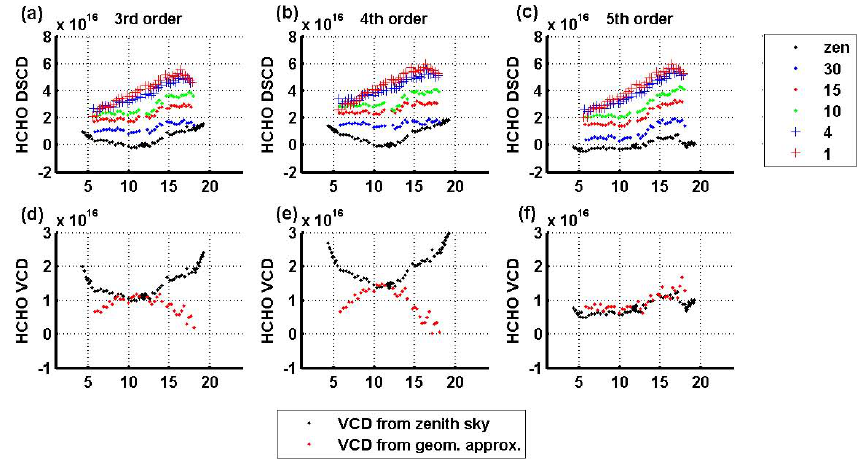
Fig. 9. Effect of the choice of the polynomial order used in the DOAS fit. (a) – (c) : Impact on the HCHO DSCDs (moleccm − 2 ) for the different elevation angles; (d) – (f) impact on the corresponding HCHO VCDs (moleccm − 2 ) obtained using two different methods described in the